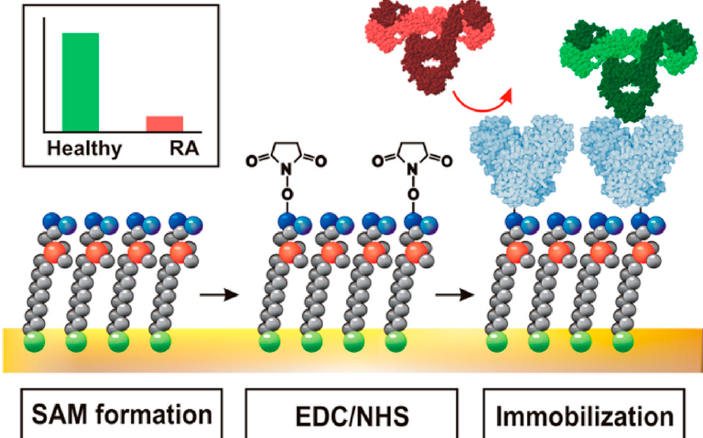
Figure 4. Preparation of carboxybetaine SAM-based SNA sensors for glycoprofiling. Reprinted from Bertok et al. [69]. SNA sensor was prepared by initial formation of carboxybetaine SAM on